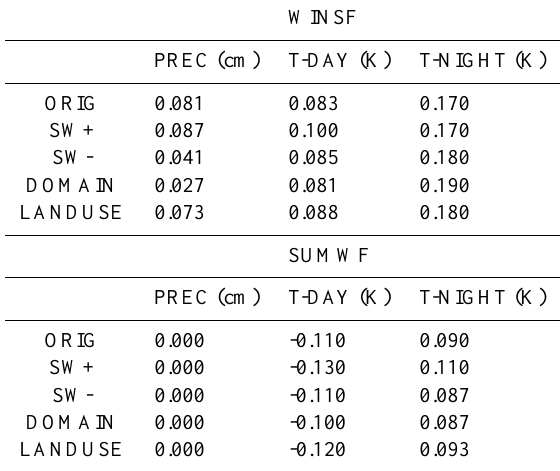
Table 1. Lake minus no-lake average precipitation (PREC), day- time temperature (T-DAY) and nighttime temperature (T-NIGHT) over the subregion surrounding the Fucino Lake shown in Fig. 2 for the original simulation (ORIG) and the sensitivity experiments of the cases SUMSF and